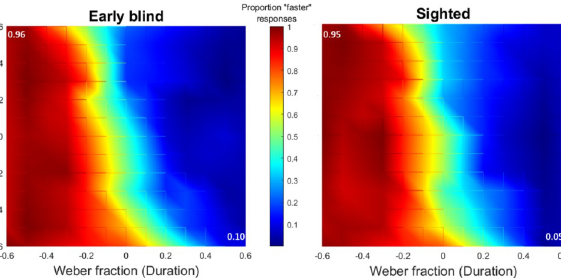
Fig 6. “Faster” proportion graph: On the distance-duration plane, the proportion of “faster” responses was plotted for each point of the plane, for the two groups separately. On the left-up and right-down corners of each graph, “faster” proportion values were